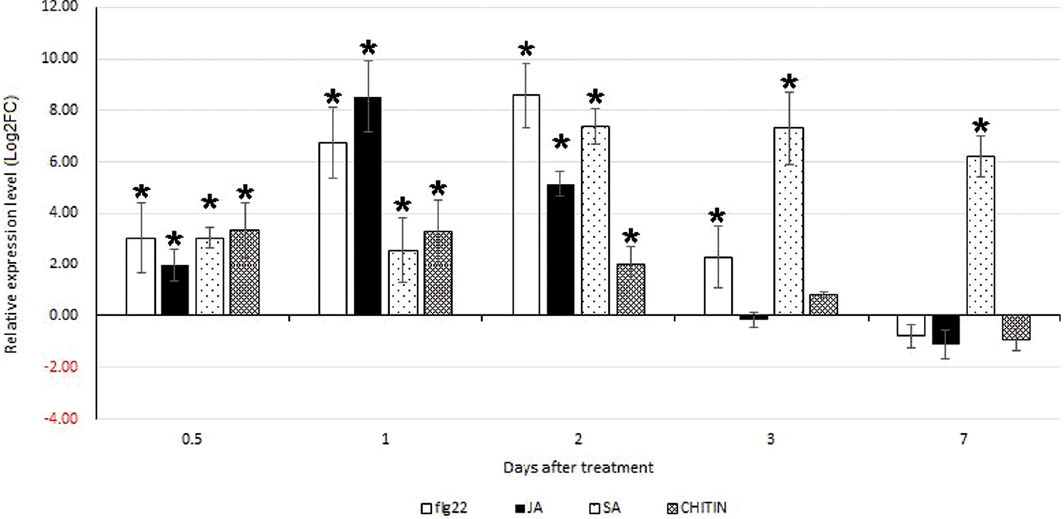
Figure 1. Expression of the receptor-like gene OsRLK3 upon treatment of rice with flg22, JA, SA, and chitin at different time points. Bars indicated standard errors of mean data (n = 3) from three biological and two technical replicates each containing a pool of three plants. Data are shown as relative expression levels of treated/untreated tissue in comparison with the control tissue. Gene expression levels were normalized using the internal reference gene OsUBQ5 . The asterisk (*) indicates significant differential expression compared with the control group (p < 0.05). flg22: flagellin 22; JA: jasmonic acid; SA: salicylic acid; CHITIN: